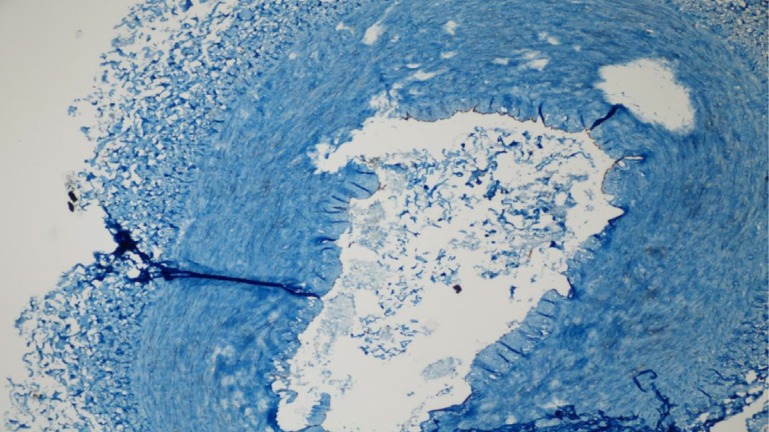
Intracellular adhesion strength molecule (ICAM) of patient no. 30 (in the ultrasonic cautery group) – endothelial damage (ICAM immunohistochemical staining of the transverse section taken from the radial artery sample) (ICAM immunoreactivity in endothelial cells -) (4×).